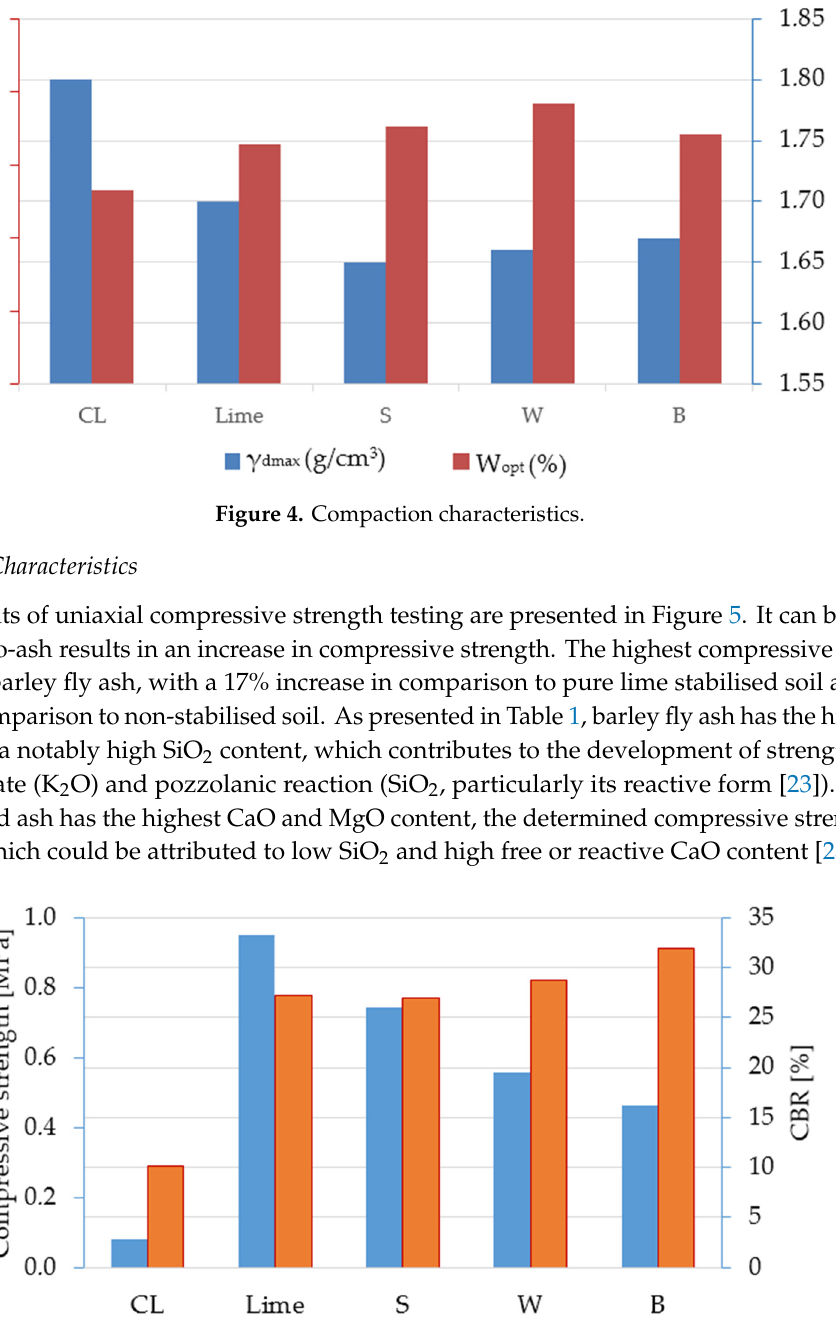
Figure 5. Results of CBR and compressive strength tests.